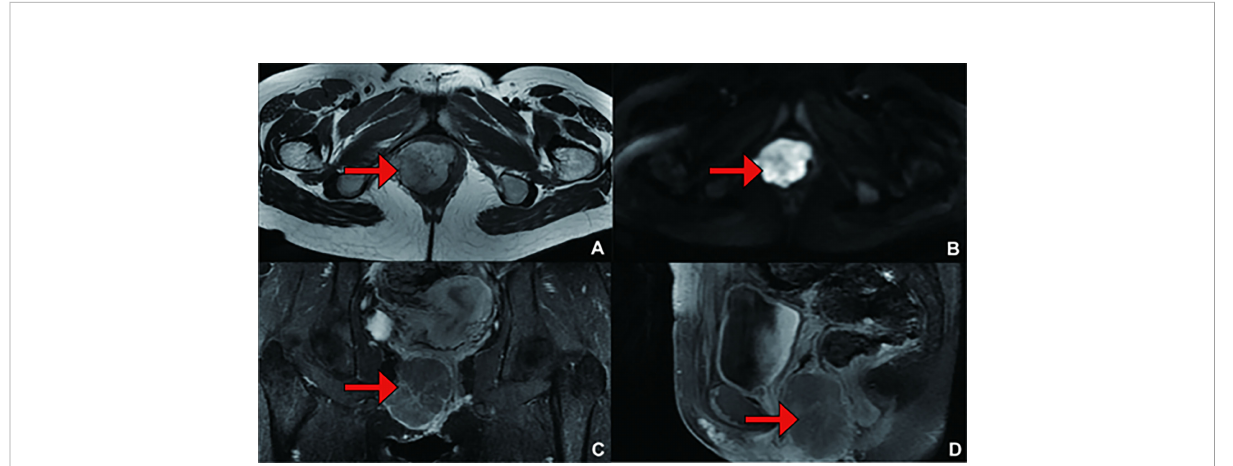
FIGURE 2 (Primary Treatment) Magnetic resonance imaging (MRI) scans: A mass on the right vulva measuring 6.0 cm*5.5 cm*4.3 cm in size, involving the right levator ani muscle, was observed. The tumour invaded the vaginal wall and disrupted the continuity of its mucous. (A) T1 weighted imaging (T1WI); (B) Diffusion Weighted Imaging (DWI); (C) Enhanced; (D)